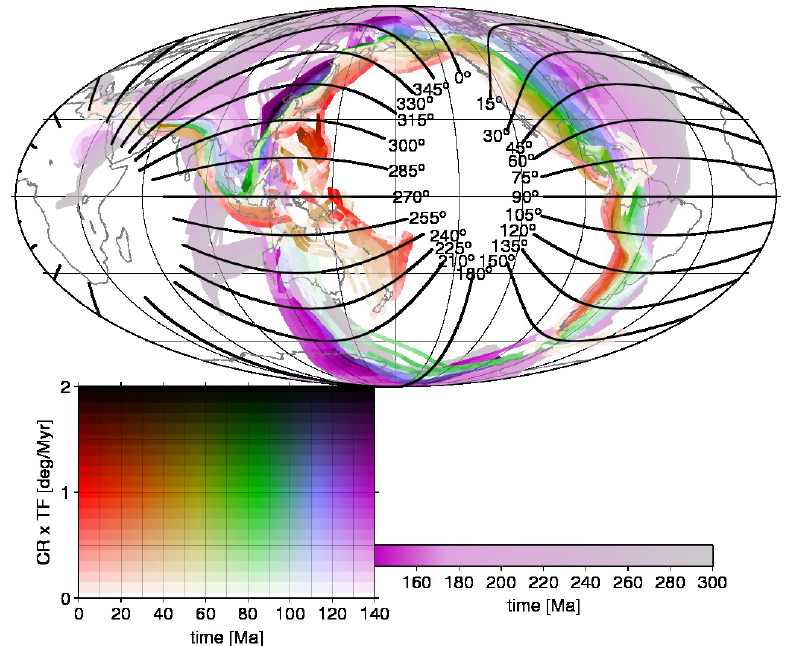
Fig. 2. Subduction history and locations of cross sections shown. The subduction history model is the same as in Steinberger and Torsvik (2012), but displayed in a different and hopefully intuitive way: Color represents time of subduction before present, and darkness represents the amount of subducted material per time and per subduction zone length, expressed in terms of convergence rate (CR) times a thickness √ factor (TF), which accounts for the increase of lithosphere thickness with age. We use TF = (age/80Myr) for age < 80Myr and TF = 1 for age > 80Myr. Convergence rates are largely unconstrained before 140Ma and therefore not considered – see Steinberger and Torsvik (2010) for details. Younger slabs are plotted on top of older ones, corresponding to a “view from above” for slabs sinking vertically at constant speed (cf. Sigloch,